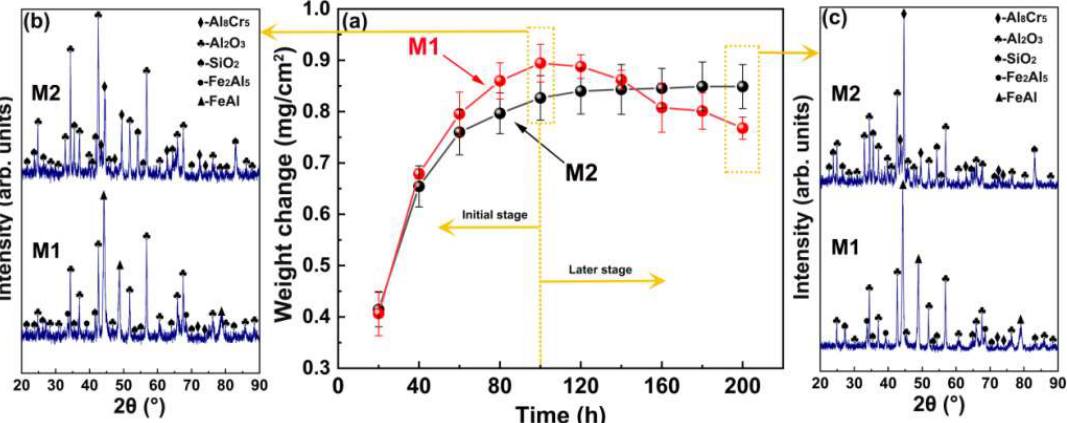
Figure 2. Corrosion kinetic curves ( a ), XRD patterns at 100 h ( b ), and XRD patterns at 200 h ( c ) of all as-deposited samples during the hot-salt corrosion tests.